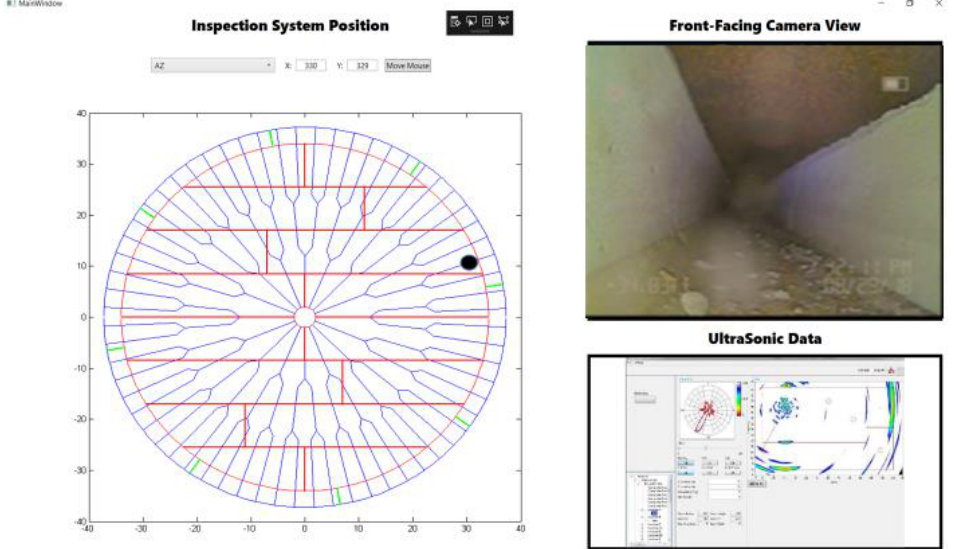
Figure 2. Graphical User Interface to display the robot position in the air slot ( left ), a video frame from a camera on the robot ( top right ), and data like that expected from non-destructive evaluation (NDE) of double-shell tanks (DSTs) ( bottom right ). The black dot indicates the position of the robot in the air slot.